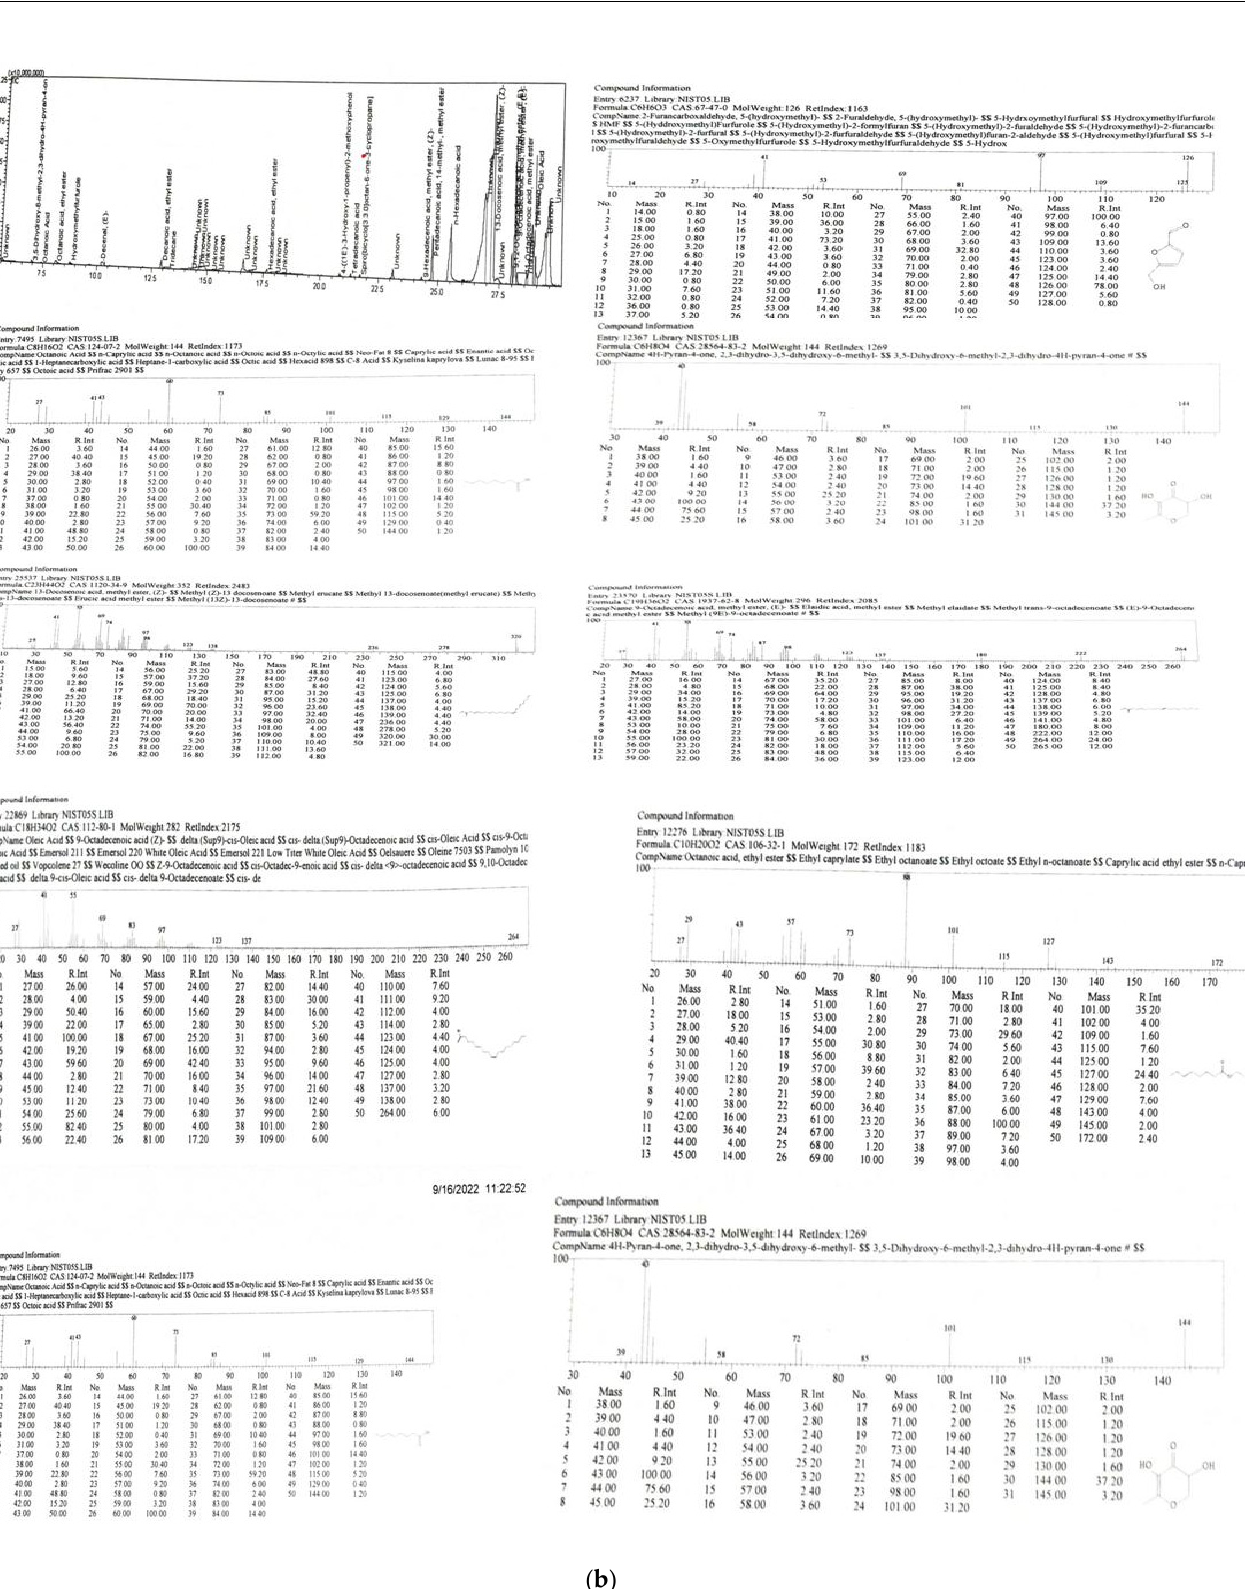
Figure 1. ( a ) Chemical constituents are found in the methanol extract of Carduus edelbergii , ( b ) total-ion chromatogram (TIC) calculated from GC-MS analysis of methanol extract of Carduus edelbergii . Table 1. Chemical constituents found in the methanol extract of Carduus edelbergii.